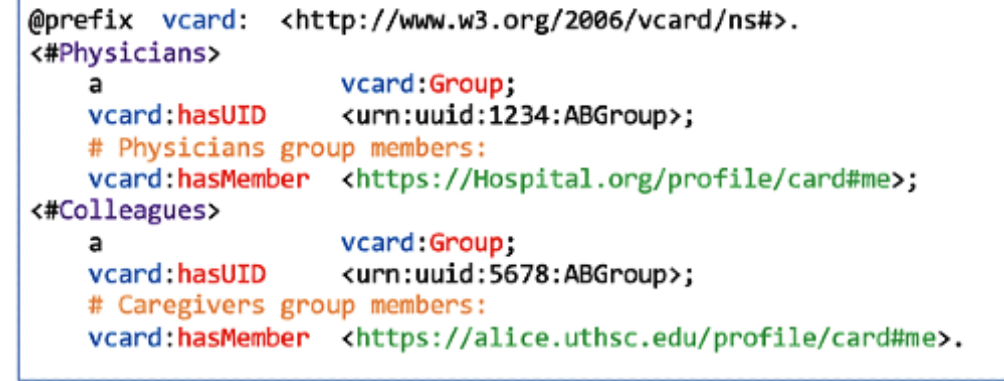
Figure 6. Bob’s work-groups document that defines Physicians and Caregivers as groups.